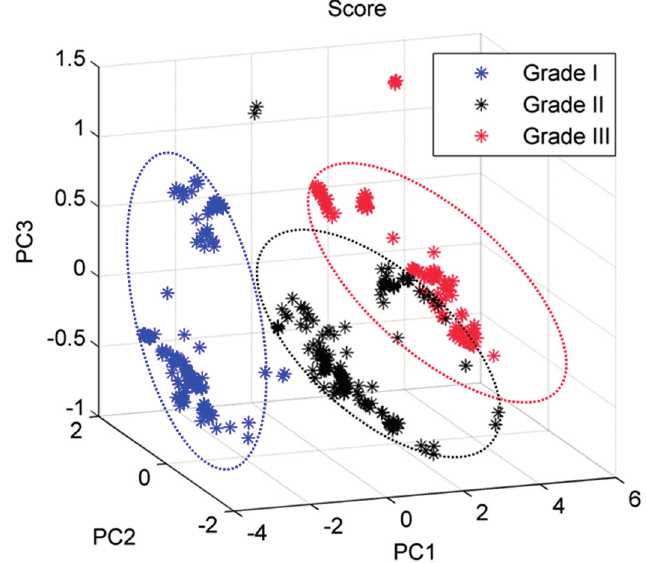
Figure 3. Multivariate-analysis based principal component analysis (PCA) algorithm